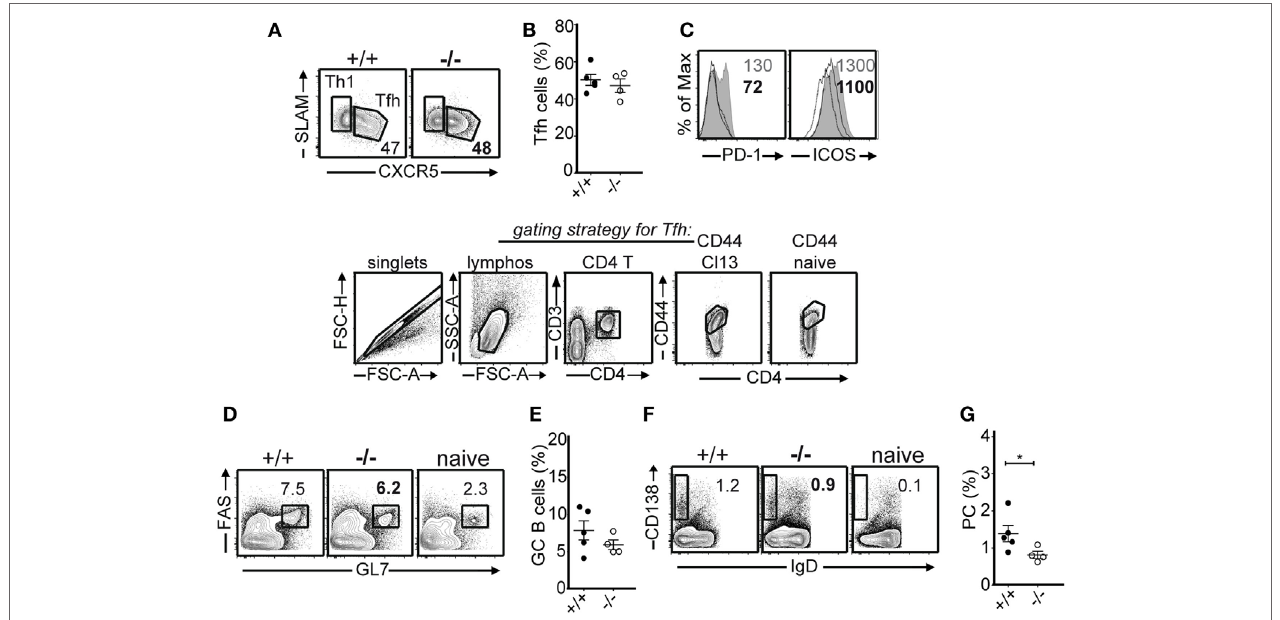
FigUre 6 | Similar germinal center responses in the absence of protein tyrosine phosphatase non-receptor 22 (PTPN22) in the lymphocytic choriomeningitis virus clone 13 infection system. (a,B) Representative FACS plots and frequency of T follicular helper (Tfh) (SLAM lo CXCR5 + ) and Th1 (SLAM + CXCR5 − ) splenic cells in PTPN22 + / + and PTPN22 − / − mice 30 days post infection (dpi) (gate: CD3 + CD4 + CD44 + ) are shown below. (c) Histogram overlay depicting PD-1 and ICOS expression levels (geometric mean) on Tfh cells from PTPN22 + / + (gray filled histogram) and PTPN22 − / − (black solid line). Naïve CD4 cells (black dotted line) were used as control. (D,e) Representative FACS plots and frequency of germinal center B cells (FAS + GL7 + ) in the spleen of PTPN22 + / + and PTPN22 − / − mice 30 dpi (gate: CD19 + B220 + ). (F,g) Representative FACS plots and frequency of plasma cells (IgD − CD138 + ) in the spleen of PTPN22 + / + and PTPN22 − / − mice 30 dpi (gate: CD19 + ). Data are derived from at least two independent experiments, one to two experiments are shown per